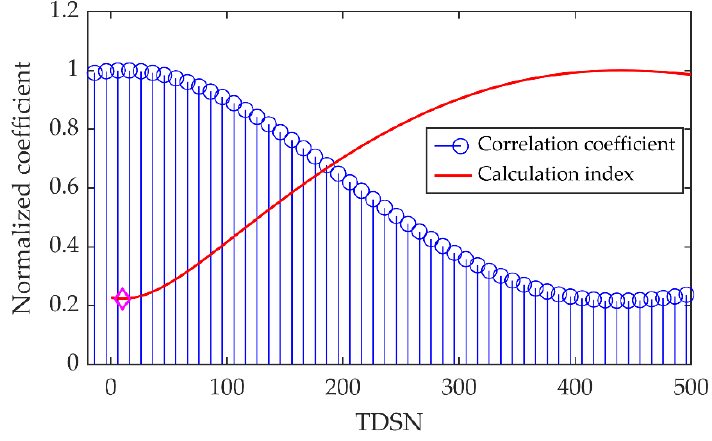
Figure 9. Comparison between the correlation coefficient and gust calculation index.